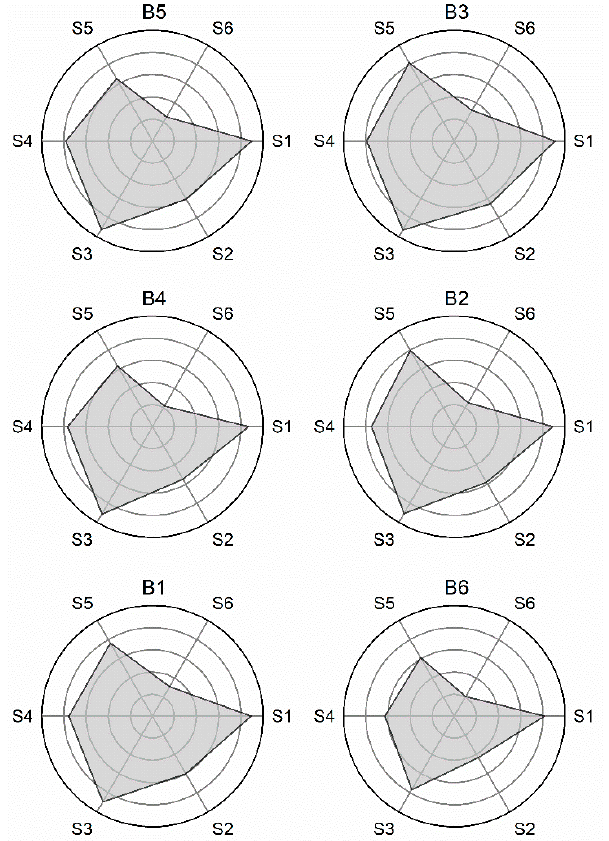
Figure 1. Radar plots (R/R 0 ) showing the fingerprints for the six analyzed virgin olive oils, anonymized as B1–B6. Sensor 1 (S1) to sensor 6 (S6) indicate the corresponding sensor in the EOS (electronic olfactory system).